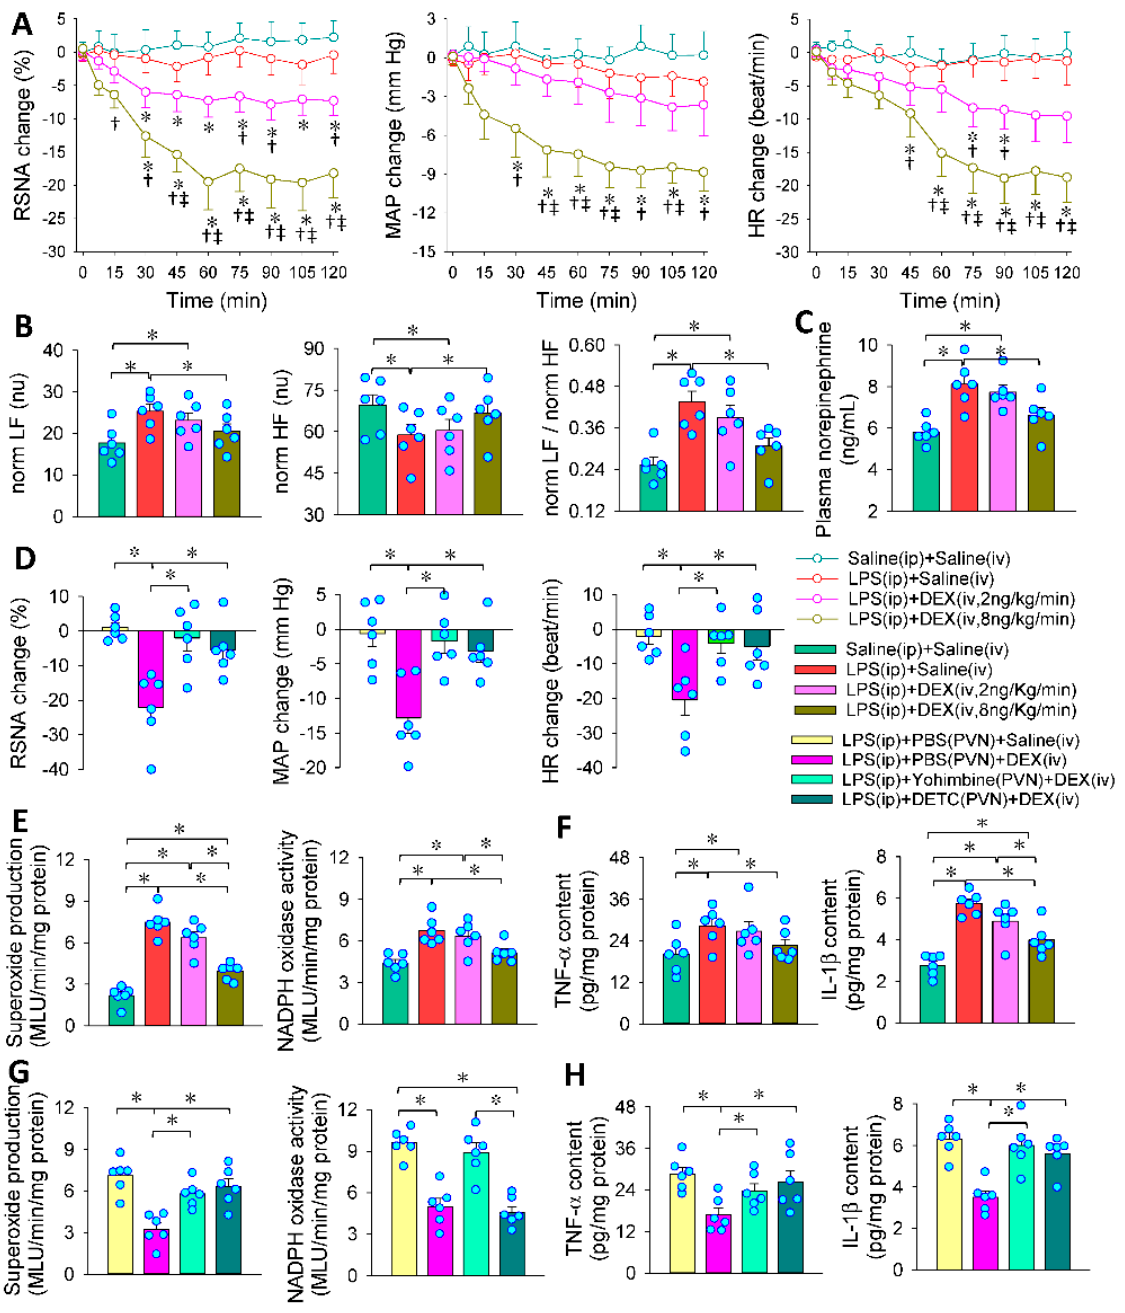
Figure 7 . Roles of the PVN in the effects of intravenous infusion (iv) of DEX on the LPS-induced sympathetic activation. Intravenous infusion of DEX for 4 h was carried out 24 h after intraperitoneal injection (ip) of LPS. Bilateral PVN microinjection was performed 5 min before the infusion of DEX. ( A ) Effects of DEX (2 or 8 ng/Kg/min, iv) on the LPS-induced RSNA, MAP and HR changes (* p < 0.05 vs. Saline+Saline) († p < 0.05 vs. LPS+Saline) (‡ p < 0.05 vs. LPS+DEX) (2 ng/Kg/min); ( B , C ) effects of DEX (2 or 8 ng/Kg/min, iv) on the LPS-induced heart rate variability changes and plasma norepinephrine level changes; ( D ) effects of PVN microinjection of yohimbine (10 nmol) or DETC (10 nmol) on the roles of DEX (8 ng/Kg/min, iv) in inhibiting LPS-induced RSNA, MAP and HR changes; ( E , F ) effects of intravenous infusion (iv) of DEX on the roles of the LPS-induced changes in oxidative stress and inflammation in the PVN; ( G , H ) effects of microinjection of yohimbine (10 nmol) or DETC (10 nmol) in the PVN on the roles of DEX in inhibiting LPS-induced changes in oxidative stress and inflammation in the PVN (* p < 0.05. n = 6).